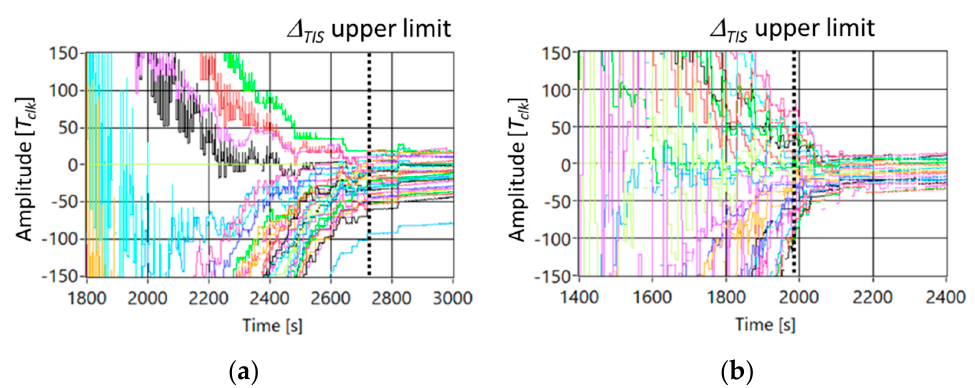
Figure 7. Experimental results of the delay among nodes in the case Nc = 49 and, ( a ) static topology, and ( b ) MSO moves according to the route#4.